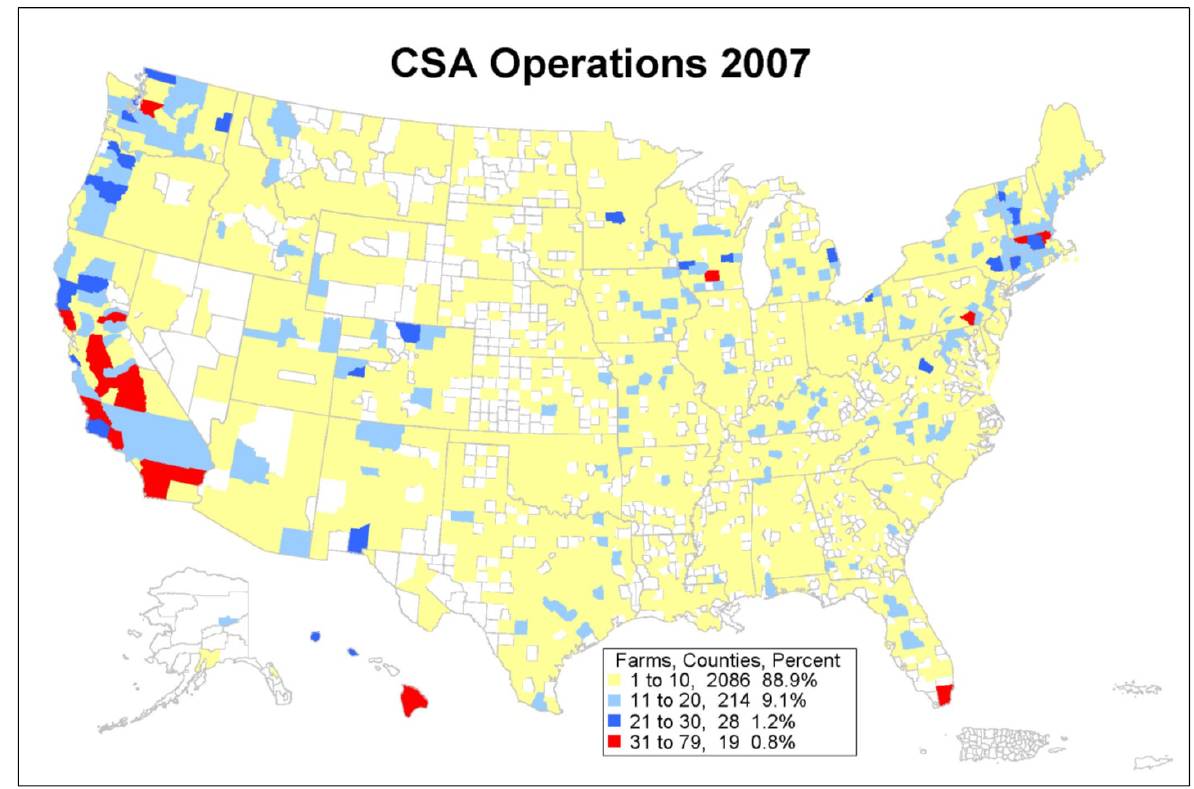
Figure 1. Number of Farms with CSA Operations by County in 2007 from Census of Agriculture Data a (republished from Hunt & Matteson,